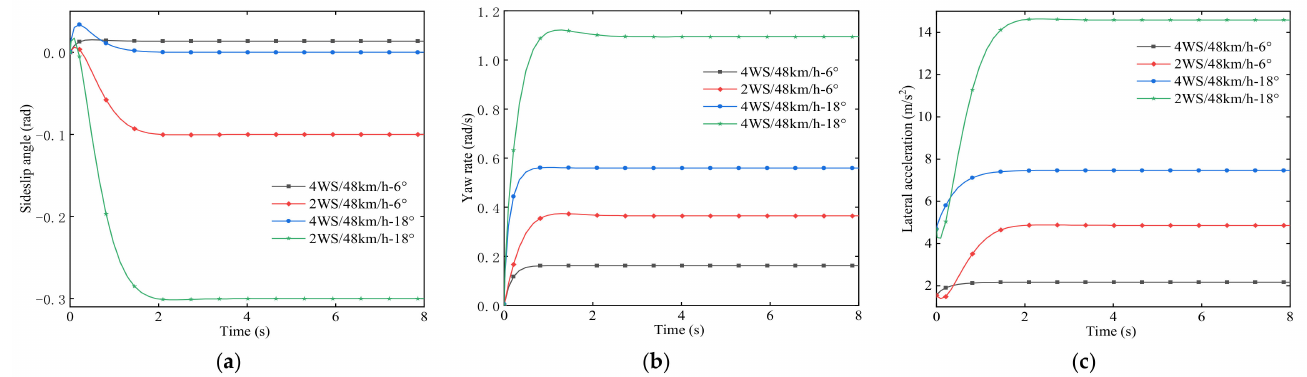
Figure 16. Simulation comparison of different rotation angles at medium speed. ( a ) Sideslip angle. ( b ) Yaw rate. ( c ) Lateral